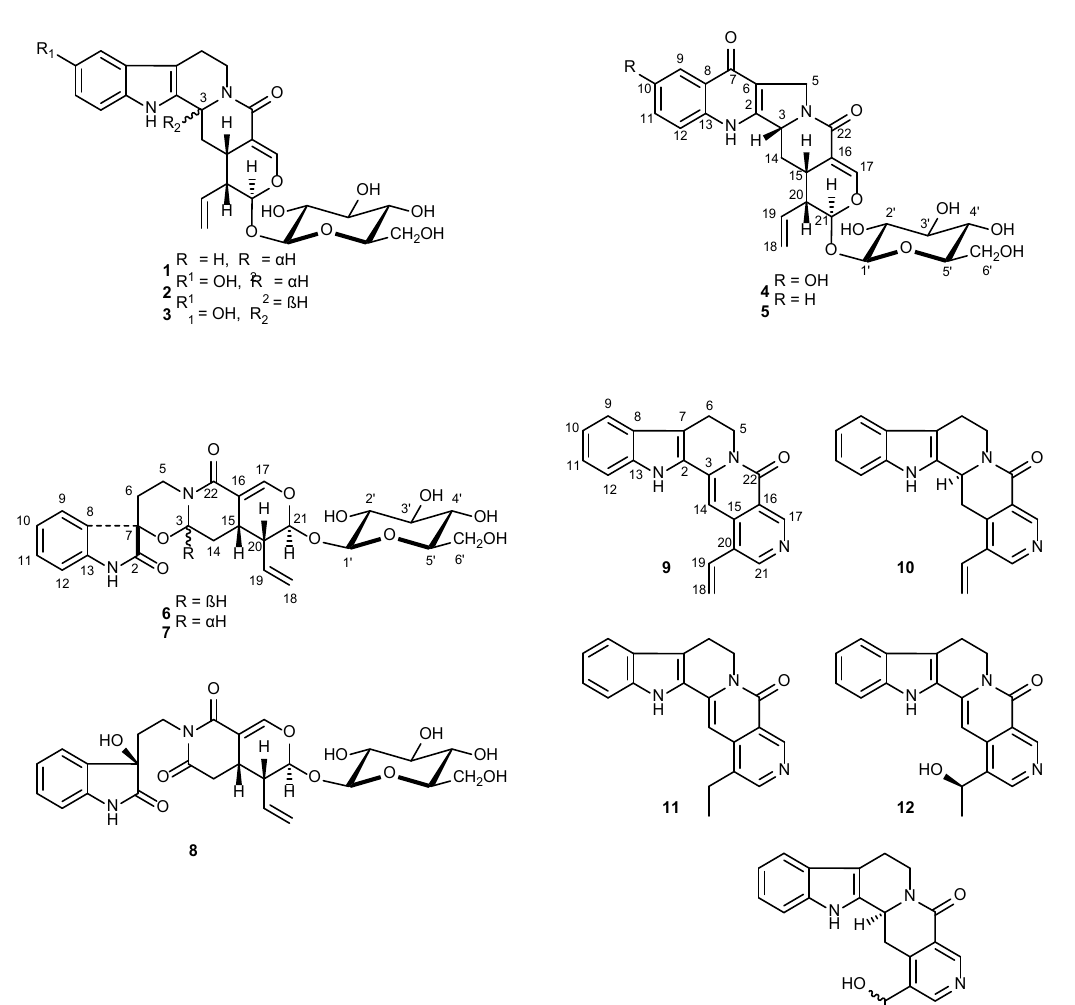
Figure 2. Structures of the isolated compounds. Numbering is in accordance to the NMR shifts given in Tables S1–S5.